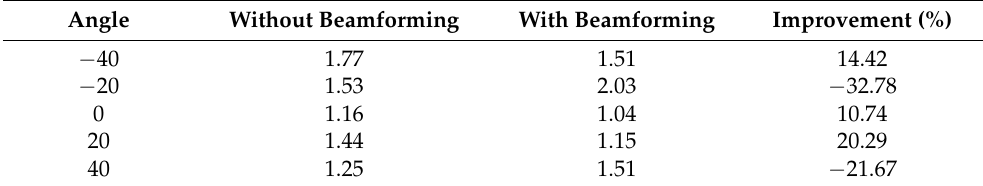
Table 4. The MAE of BR at five different angles. Individual MAE at all three distances (0.9, 1.2 and 1.5 m) are combined at each